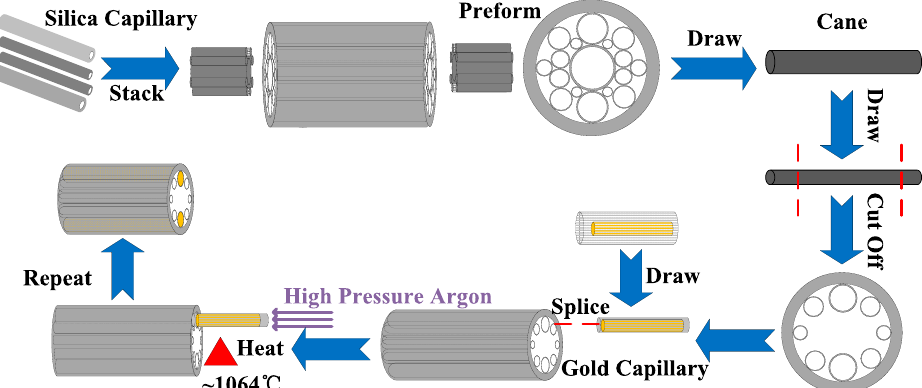
Figure 10. The schematic diagram of the proposed gold wires-filled HC-NCF fabrication by the combination of the stack and draw technique and pressure-assisted splicing technique.